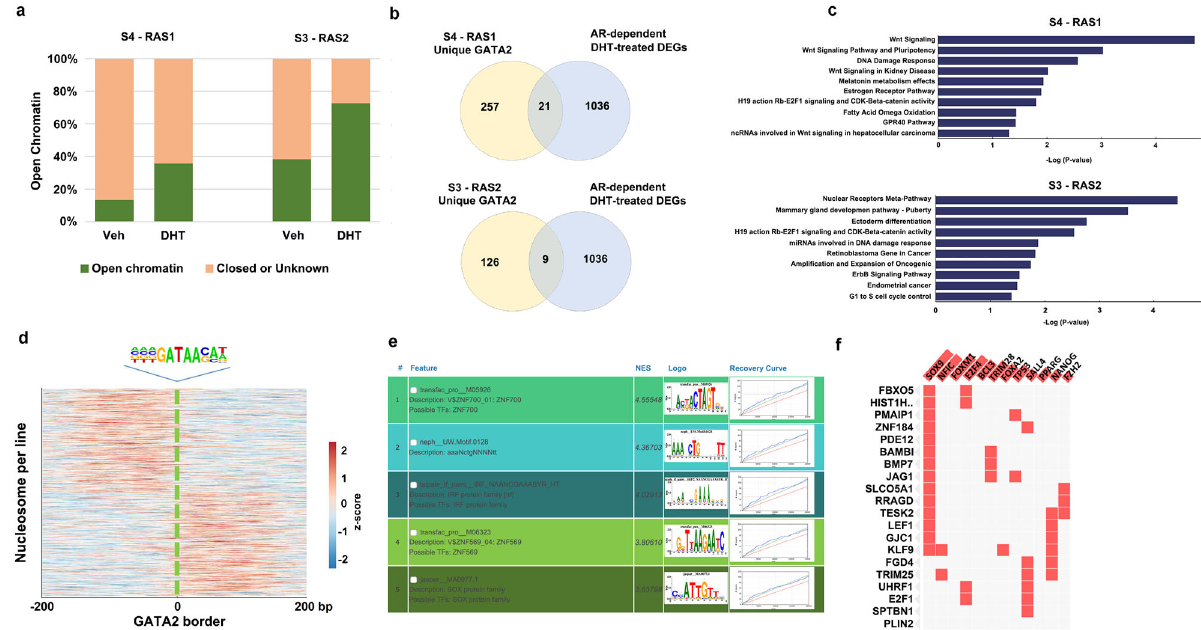
Fig. 5 GATA2 governing nucleosome states switching from Veh to DHT-treated conditions. a Open chromatin was detected by ATAC-seq for GATA2 binding sites associated with nucleosome states switching in Veh and DHT-treated conditions respectively. b Overlapping between GATA2-associated nucleosome state switching genes and AR-regulated differentially expressed genes in DHT-treated condition. Differentially expressed genes were detected with p value <0.05 and | log2(Fold Change)| > 1. c KEGG pathway analyses showing the top pathways in S4-RAS1 and S3-RAS2 respectively. d The location of the GATA2 motif between ChIP-exo borders relative to the density map of MNase-seq reads for positioned nucleosomes. e The prediction of regulatory features and modules by i-cisTarget illustrating several top enriched TF motifs in unique GATA2-associated nucleosome state switching genes. f SOX9 is the most enriched co-binding TF on WNT signaling genes identi fi ed by a publicly available database that collected all ChIP-seq of TFs from ENCODE and